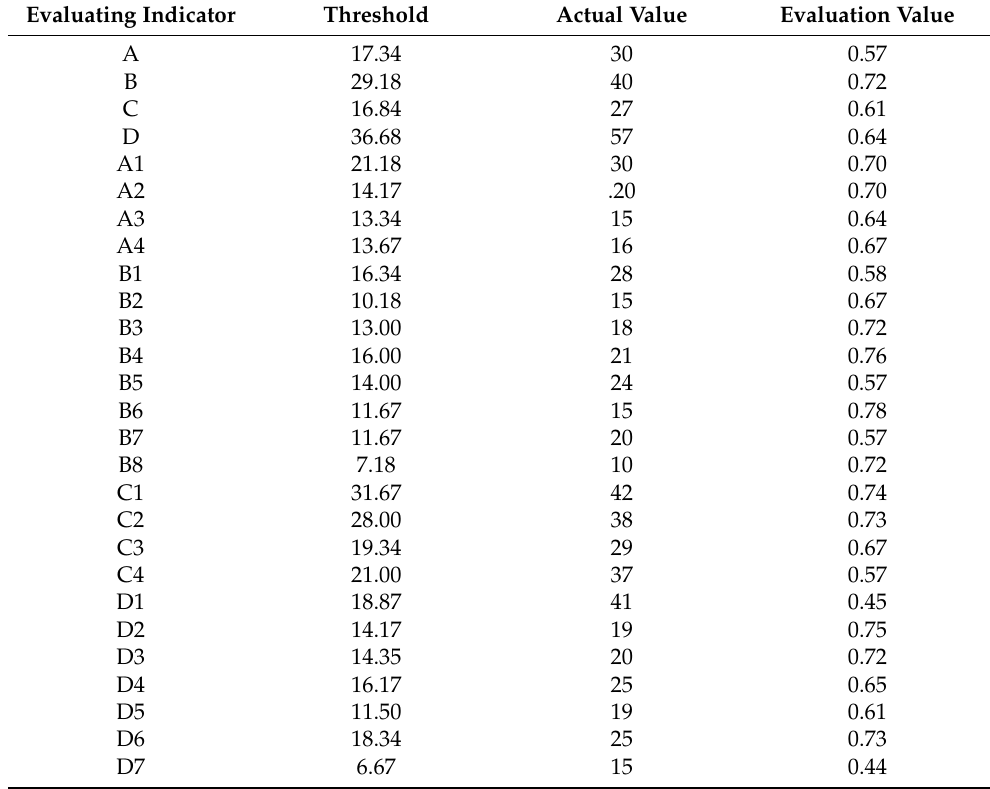
Table 1. Evaluation value of each evaluation index.